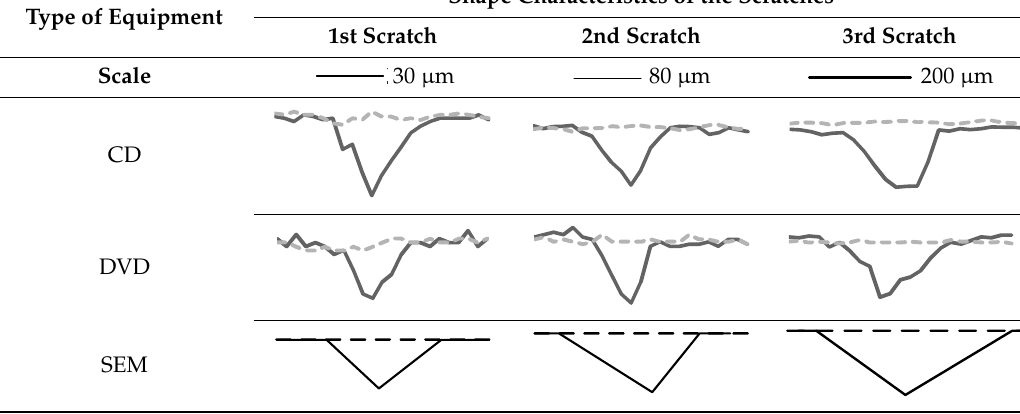
Figure 9. Shape characteristic measured by SEM of ( a ) 55 µm, ( b ) 94 µm, ( c ) 332 µm scratch. 4.4. Rotating Speed and Scratch Sizes Detected by CD and DVD Pick-Up Heads A speed variation of the rotating disk controlled by a new designed microcontroller has to be studied to find an optimistic speed for CD and DVD pick-up heads. A speed of 500–1500 rpm is varied and the results are shown in Table 4, while the error compared to the SEM results are shown in Figure 10. Table 4. Comparison of rotating speed and scratch sizes detected by CD and DVD pick-up heads. Sizes Measured (μm) 1st Scratch (55 μm)